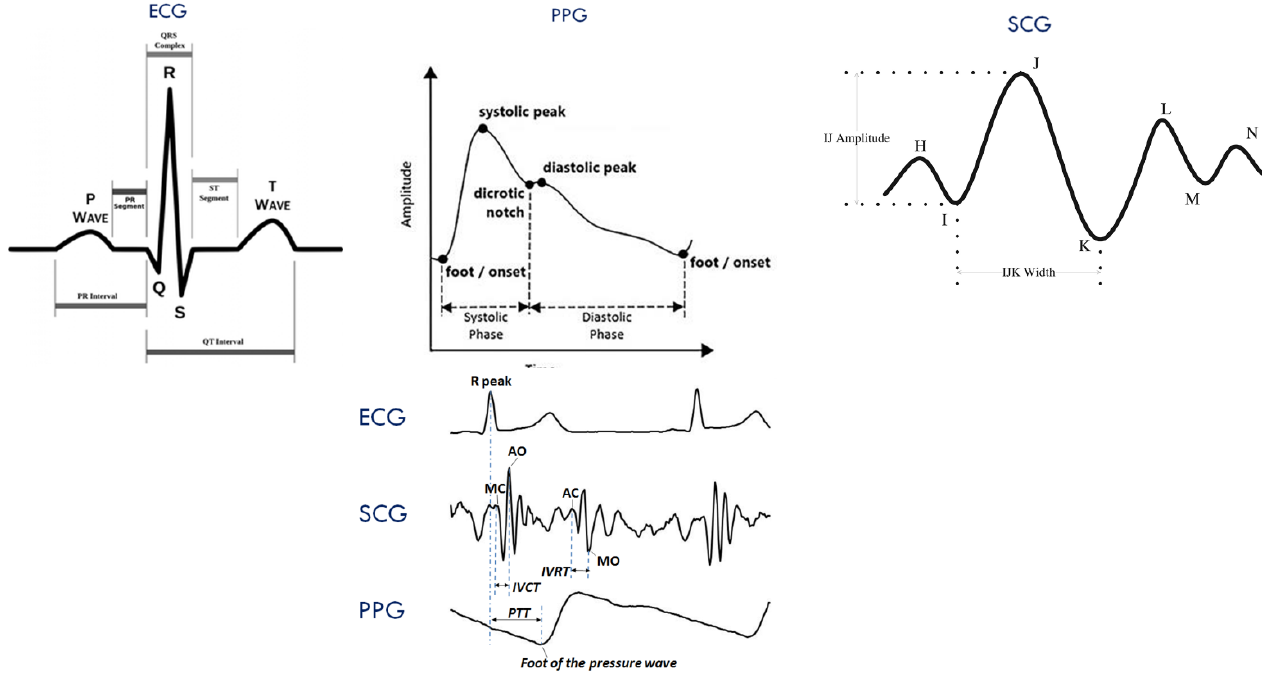
Figure 4. Biomedical signals used for recent BP measurement techniques (noninvasive and cuffless) [119] CC 4.0.